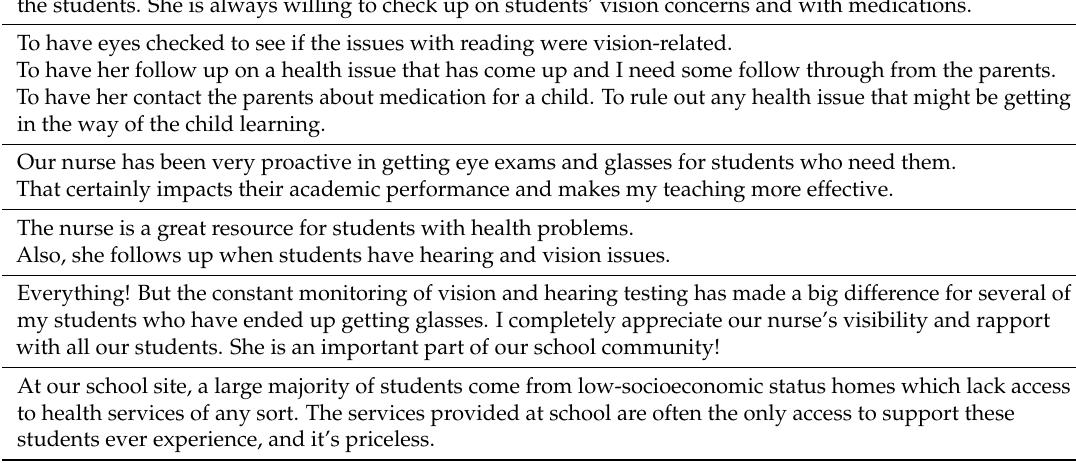
Table 2. Examples of quotes of teachers in demonstration school with full-time nurses about benefits of screening provided by